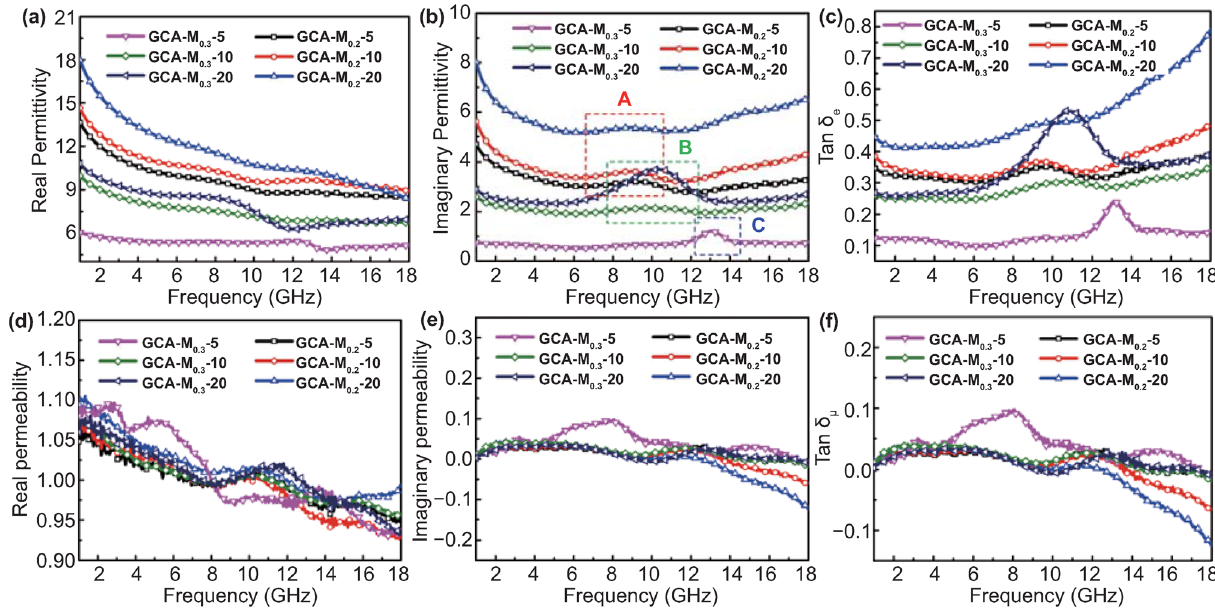
Fig. 6 Frequency dependence of ( a ) real permittivity, ( b ) imaginary permittivity, ( c ) dielectric loss tangent, ( d ) real permeability, ( e ) imaginary permeability, and ( f ) magnetic loss